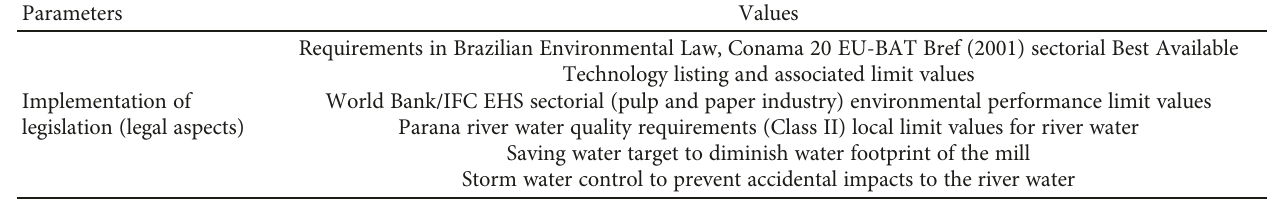
Table 1: List of policy measures designed for an industrial WWTP in